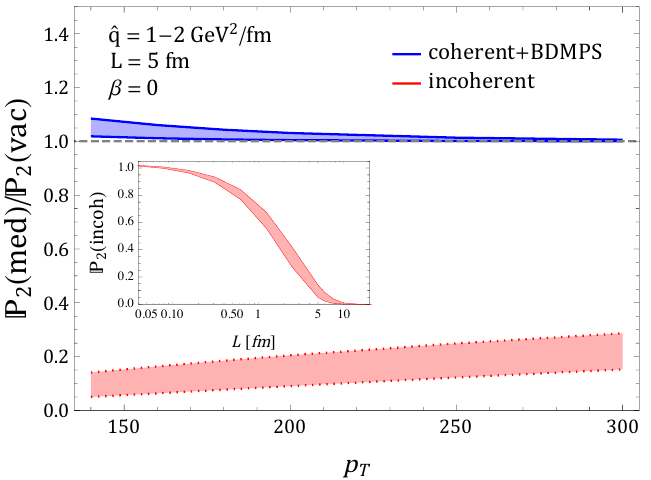
Figure 3. (Color online) The ratio of the two-pronged probability for two scenarios described in the text compared to the vauum. In the inset, we plot the two-pronged probability for incoherent energy loss at for the lowest p -bin as a function of varying the medium T